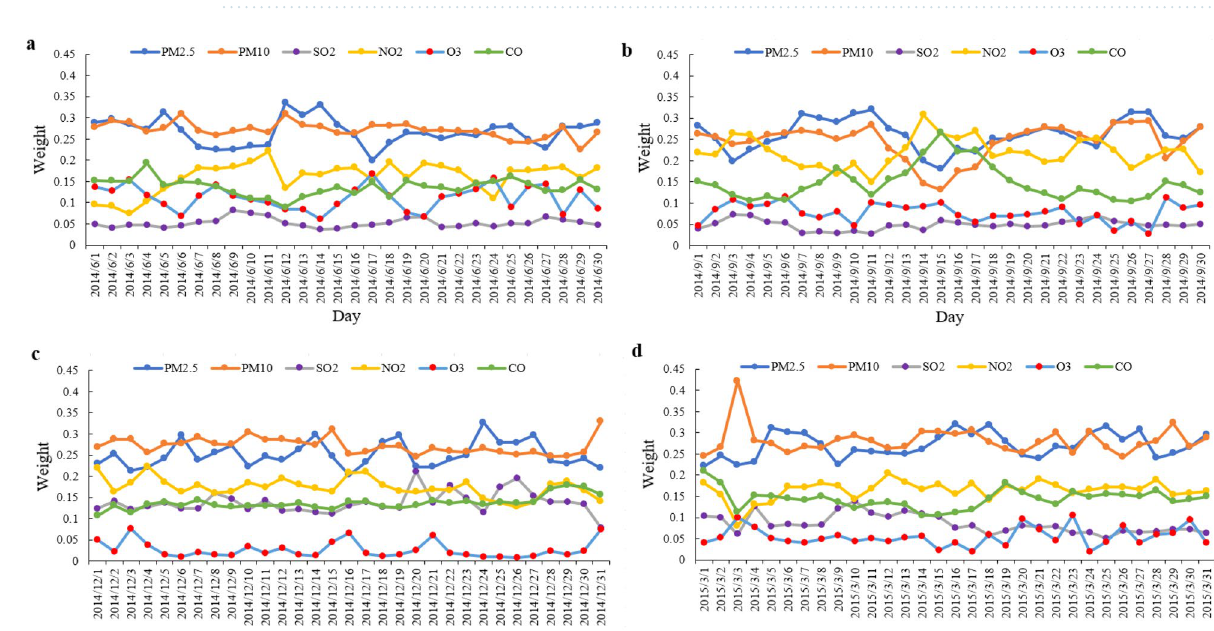
Figure 4. Weight of pollutants in different seasons. ( a ) Weight of pollutants in summer; ( b ) weight of pollutants in autumn; ( c ) weight of pollutants in winter; ( d ) weight of pollutants in